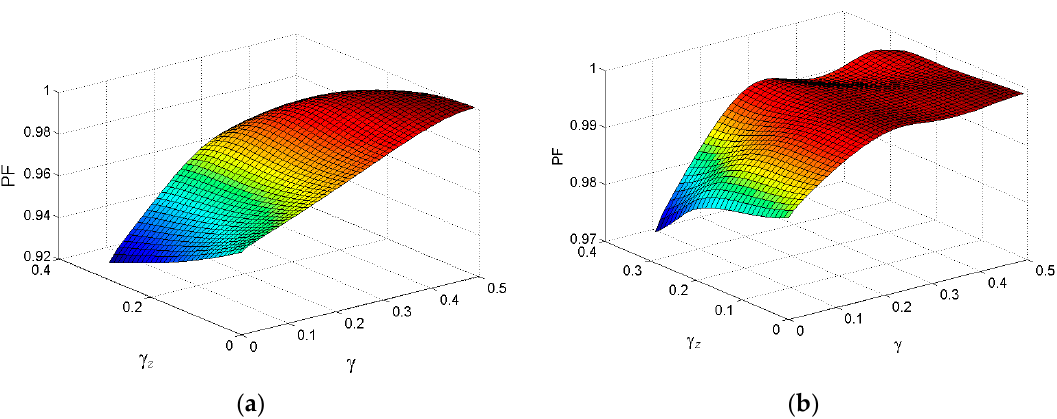
Figure 12. Power factor value as function of γ and γ z : ( a ) Two cell converter N = 2, ( b ) four cell converter, N = 4.